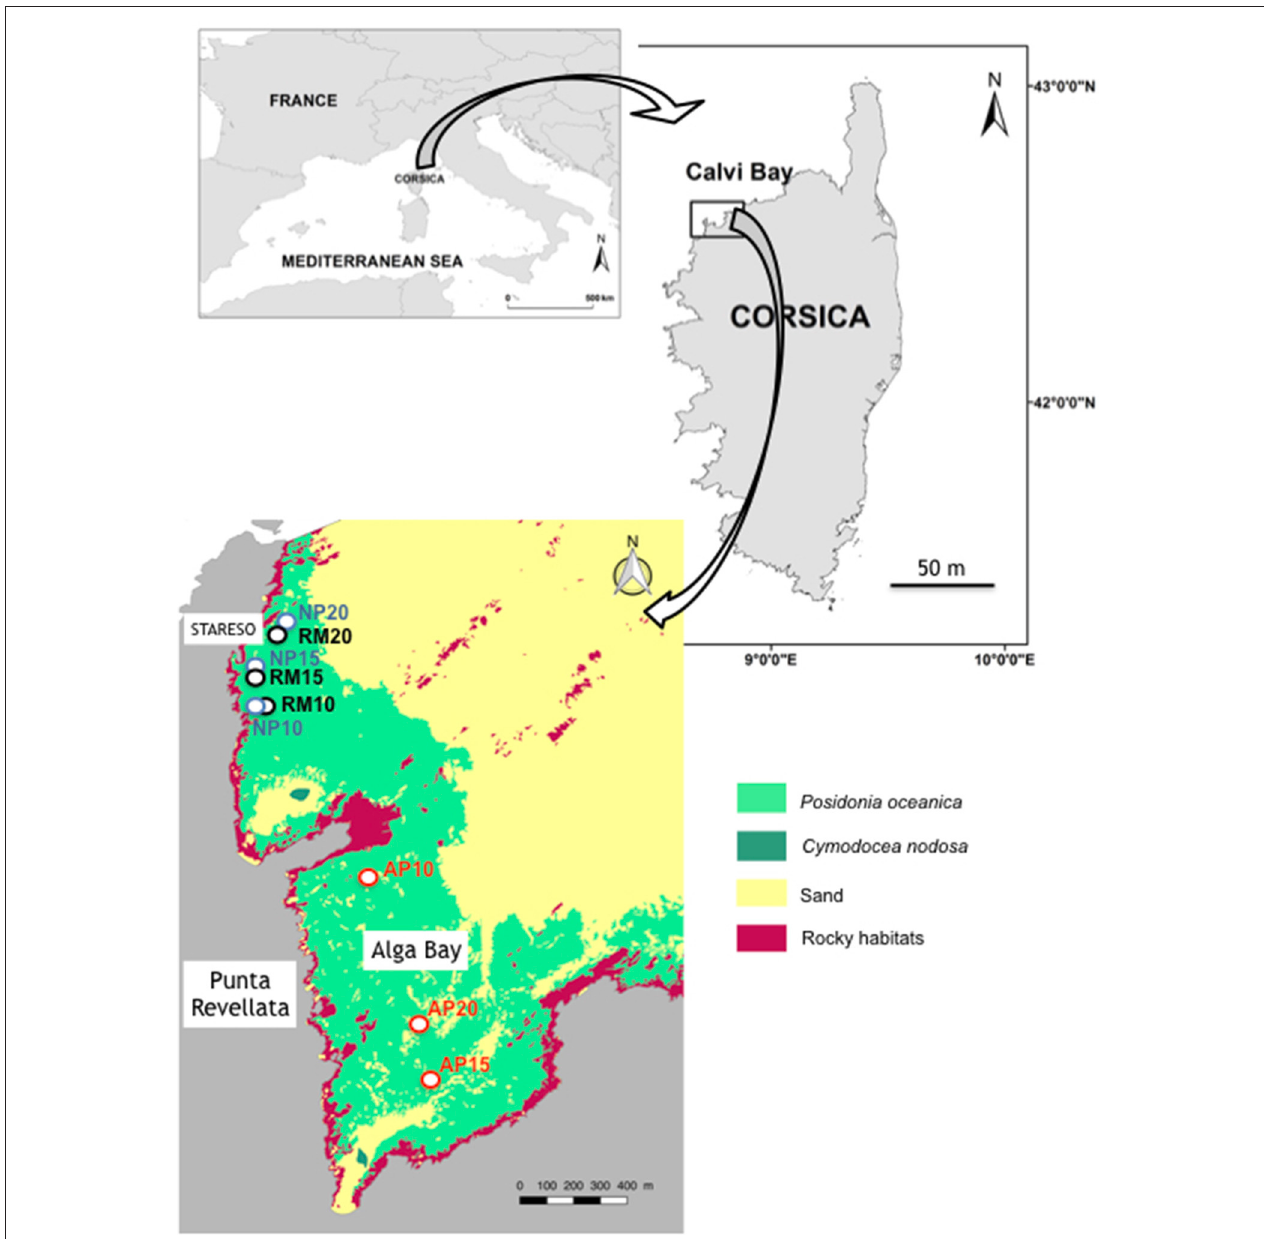
FIGURE 2 | Location of study sites in the Calvi Bay. RM, reference meadow; NP, natural patch; AP, anchoring patch. Ten, fifteen, and twenty numbers are depths. Mapping data of marine habitat are from Abadie (2012).